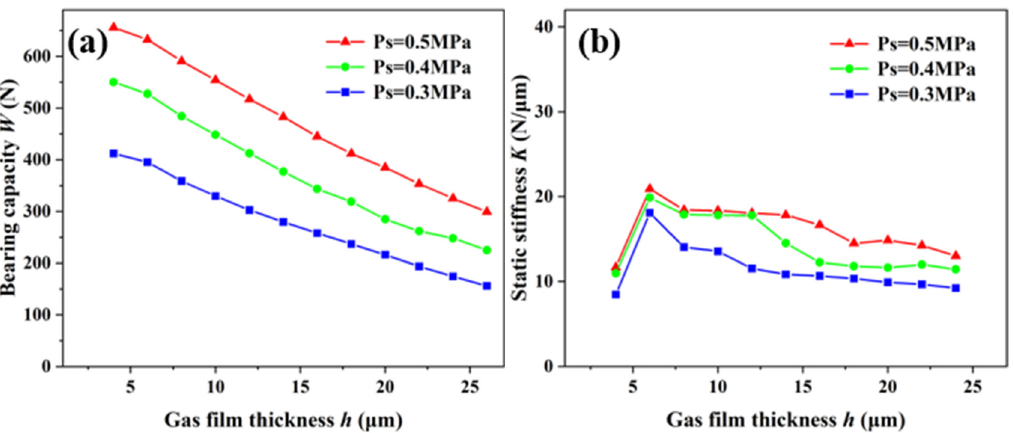
Figure 7. Static characteristics of aerostatic bearing under different gas-supply pressures: ( a ) bearing capacity; ( b ) static stiffness.